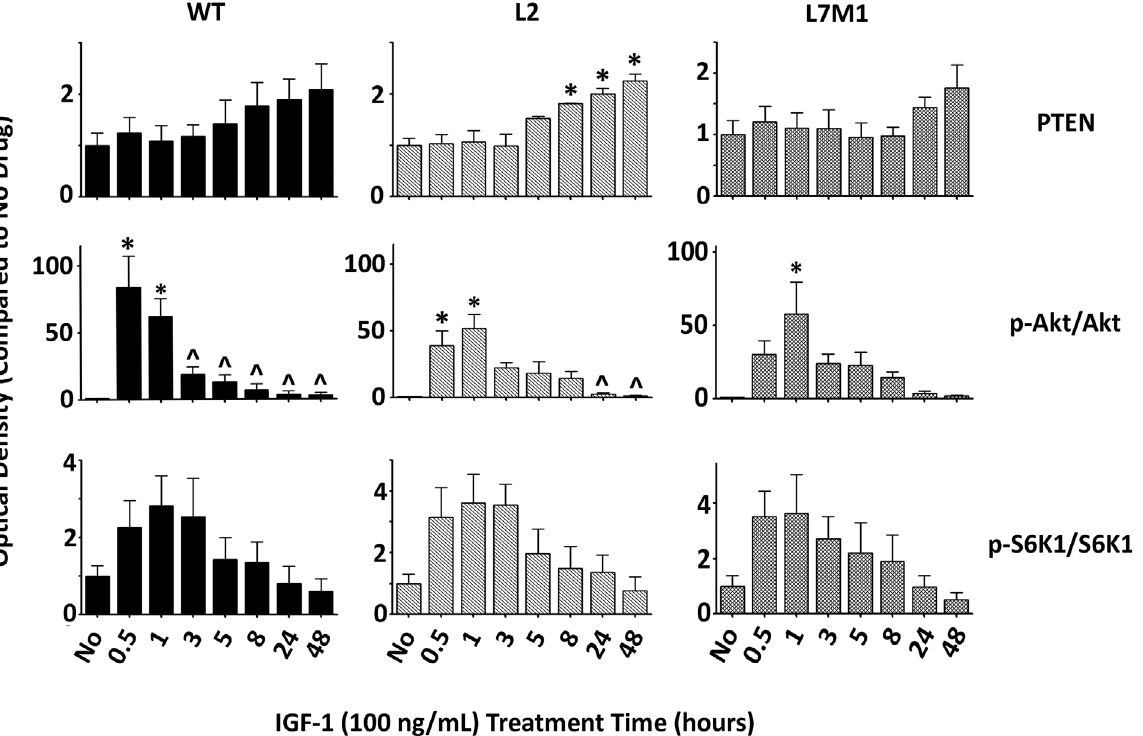
Fig 7. Immunoproteasome Modulates RPE Cell Signaling after IGF-1 Stimulation. RPE cells isolated from WT, L2, and L7M1 mice were serum starved for 24h and treated with IGF (100ng/mL) for the indicated time points. Results are the optical density of PTEN, p-Akt/Akt, and p-S6K1/S6K1 protein content. Data are shown as a proportion of each mouse strains ’ control (day 0) and represent the mean ± S.E. of 3 – 6 repeats. ( * , p (cid:1) 0.05 by one-way ANOVA with Dunnett ’ s post-test compared to the ‘ No Drug ’ values; ^, p (cid:1) 0.05 by one-way ANOVA with Dunnett ’ s post-test compared to the ‘ 30 min ’